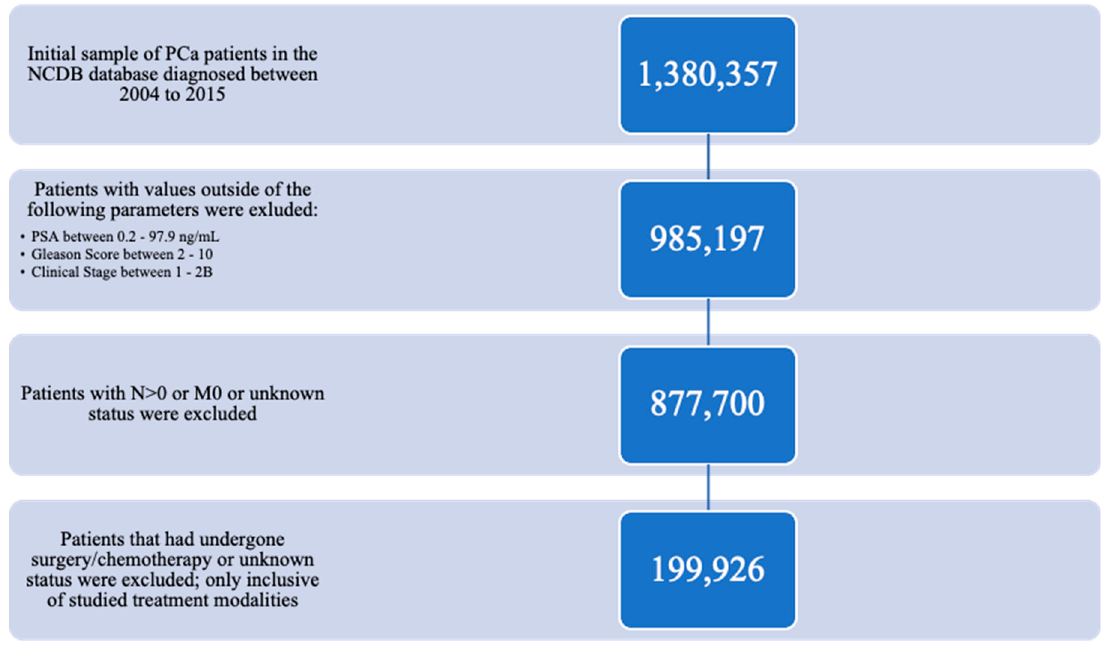
Figure 1. CONSORT diagram—selection of the prostate cancer patient population from NCDB 2004–2015.